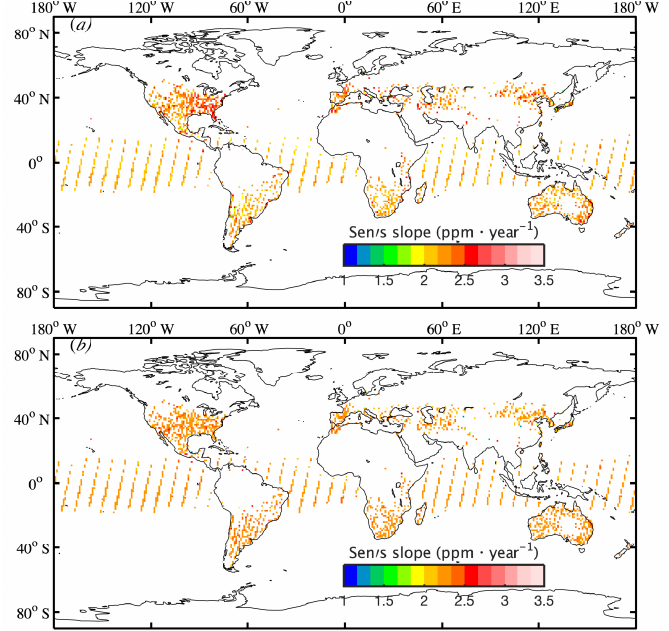
Figure 18. Global map of the mean trend in XCO 2 calculated from ( a ) the satellite seasonal mean XCO 2 dataset and ( b ) the CT-modeled XCO 2 seasonal dataset using the S-K method. Sen’s slope represents the trend slope calculated using the S-K